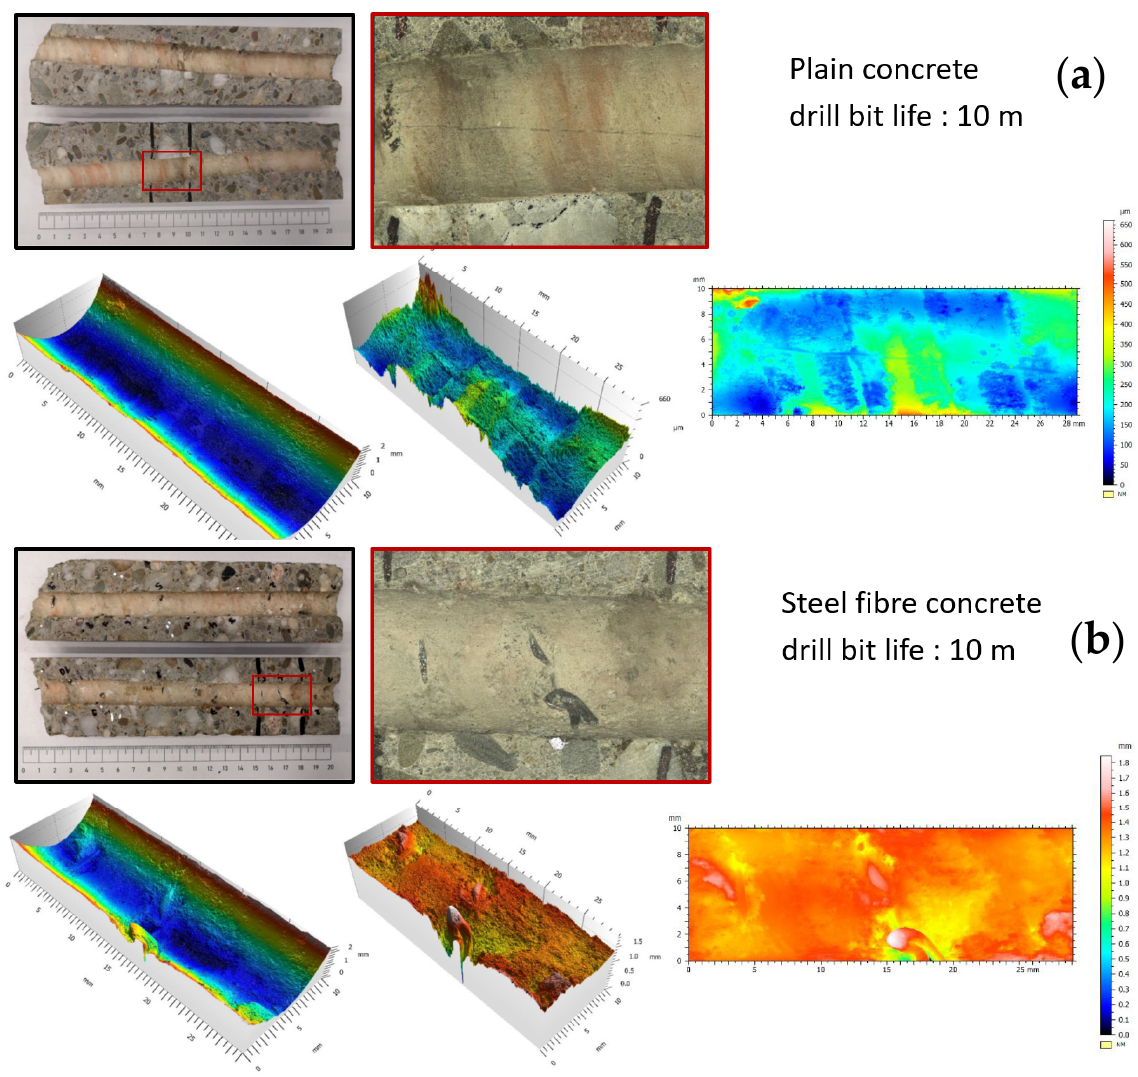
Figure 3. Microscopic assessments of borehole in cored-out specimens in plain concrete ( a ) and SFRC ( b ).